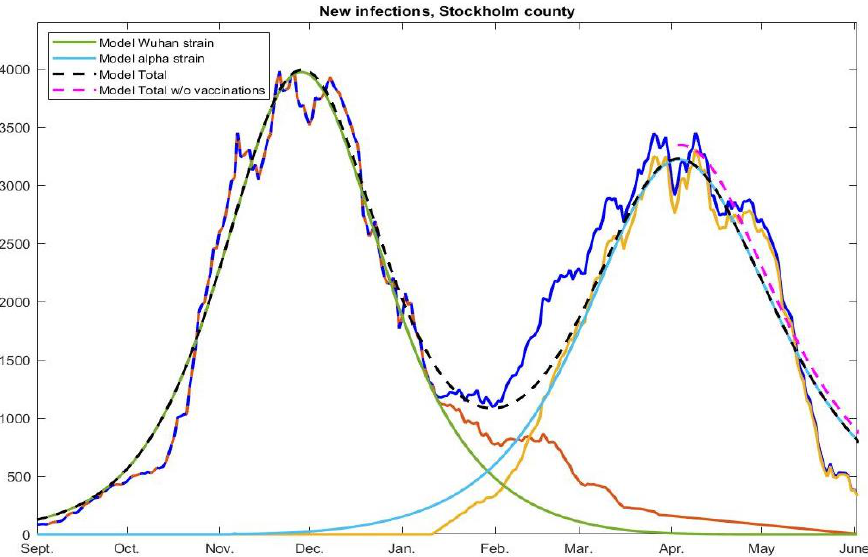
Figure 6. Actual and modeled curves using artificial pre-immunity. The brown-orange, yellow, and blue curves display measured cases, separated into Wuhan-strain, alpha-strain, and total, respectively, same as in Figure 2 (so reweighted as before). The green, light-blue, and dashed black display corresponding curves for our model. Finally, the pink dashed curve shows total model output in the absence of vaccinations (only displayed during April–May 2021). Clearly, if this model is correct, the vaccination campaign had virtually no part in the final demise during May 2021, contrary to popular